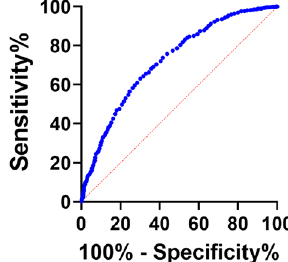
Figure 2. ROC curve for the APOB levels. The area under the ROC curve was 0.722 (95% CI 0.70–0.74, P < 0.05). When the most optimal cut-off value of the APOB level was 0.895 g/L, the sensitivity was 0.699, and the specificity was 0.630. Abbreviations as in Table 1. The figure was developed by GraphPad Prism software (version